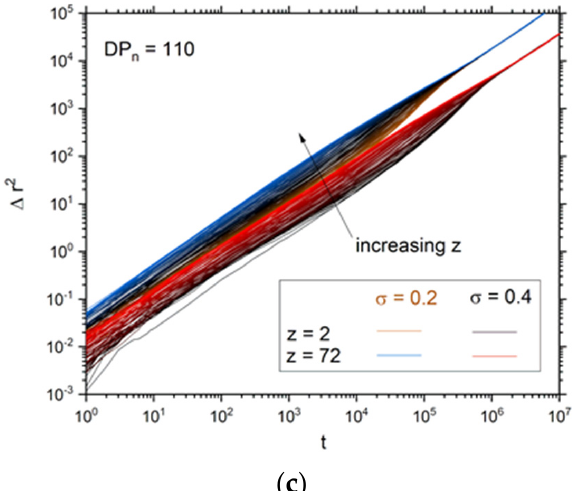
Figure 5. The mean squared displacement (MSD) of solvent and polymer molecules ( a ) and MSD/ t ( b ) as functions of time for solvent. The degrees of polymerization DP n are given in the insets. The case of σ = 0.3. MSD for solvent with various initial surface proximities (cross-section number z ) for two selected grafting densities ( c ).